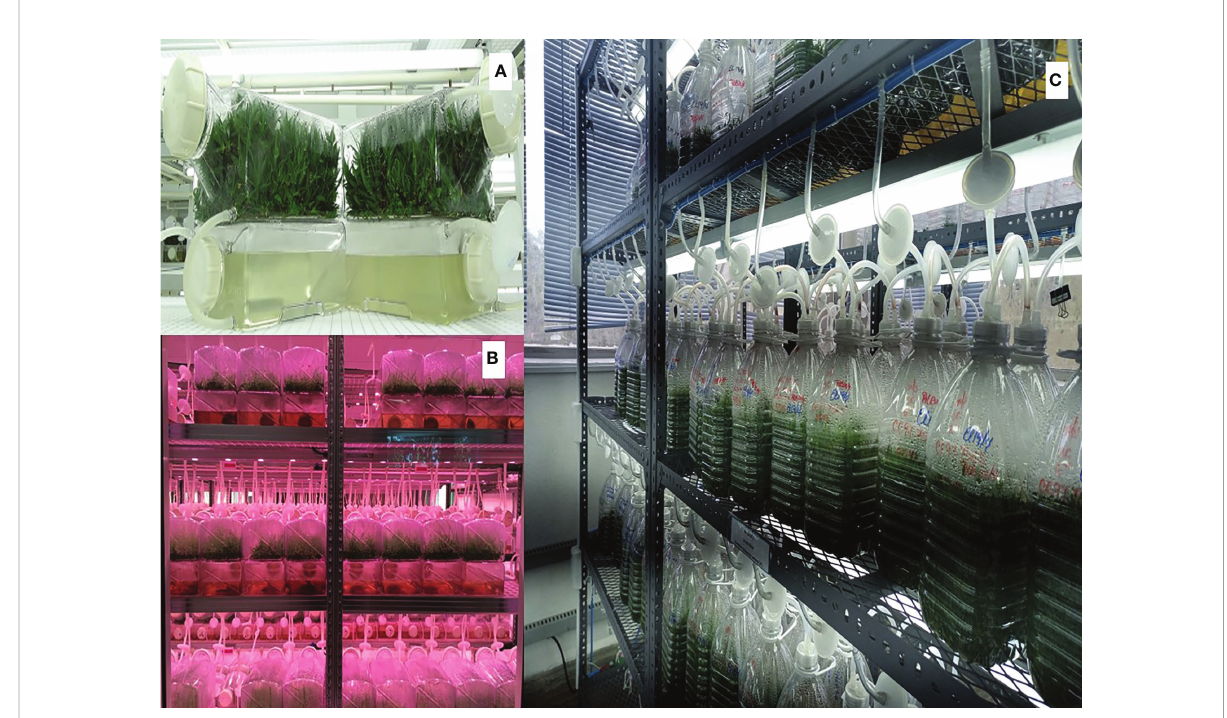
FIGURE 4 Illustration of the production of sugarcane plantlets using temporary immersion bioreactors. (A) SETIS ™ bioreactor; (B) Florida Crystals Corporation, using SETIS ™ technology (https://setis-systems.be/about/about-setis); (C) CALESA facilities using BIT ®